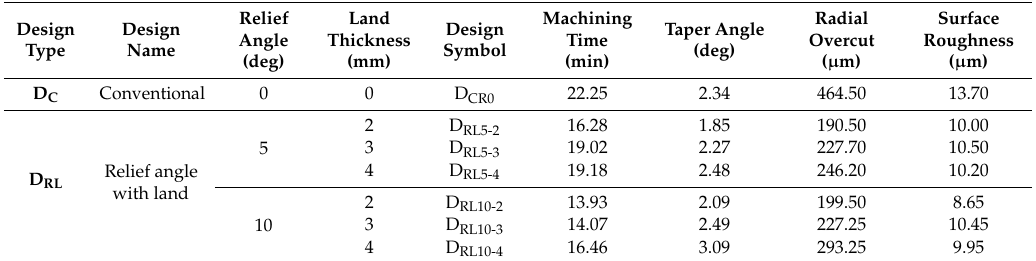
Table 6. Experimental results of stage-2 experimentation.